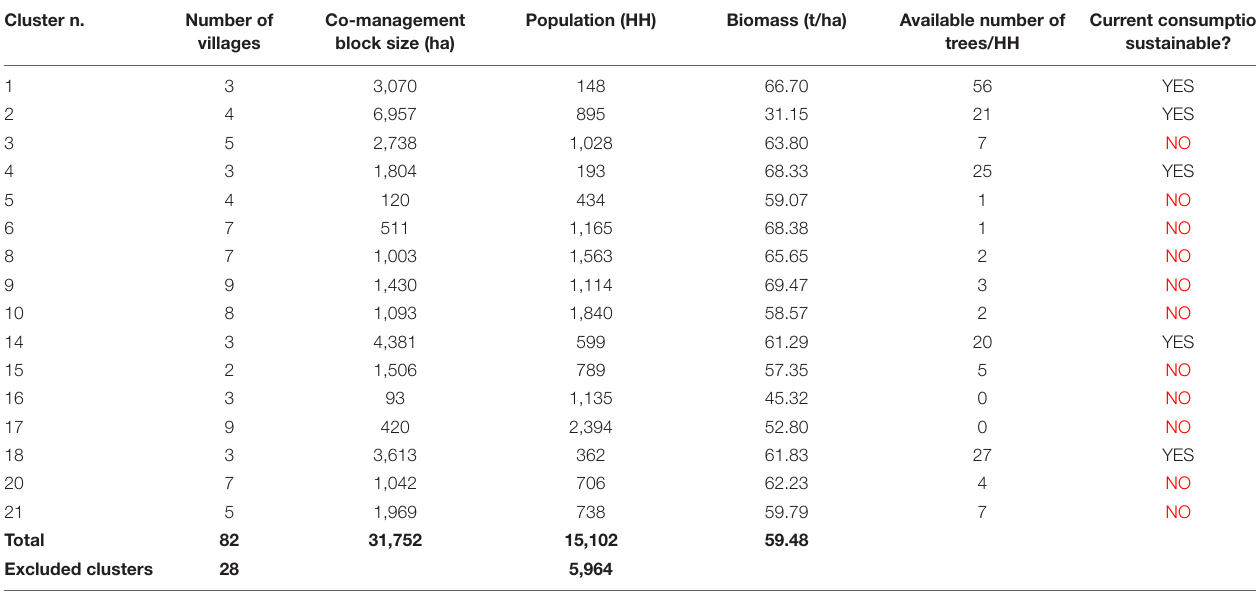
TABLE 5 | Current situation in the base year (2015) for each cluster. Cluster